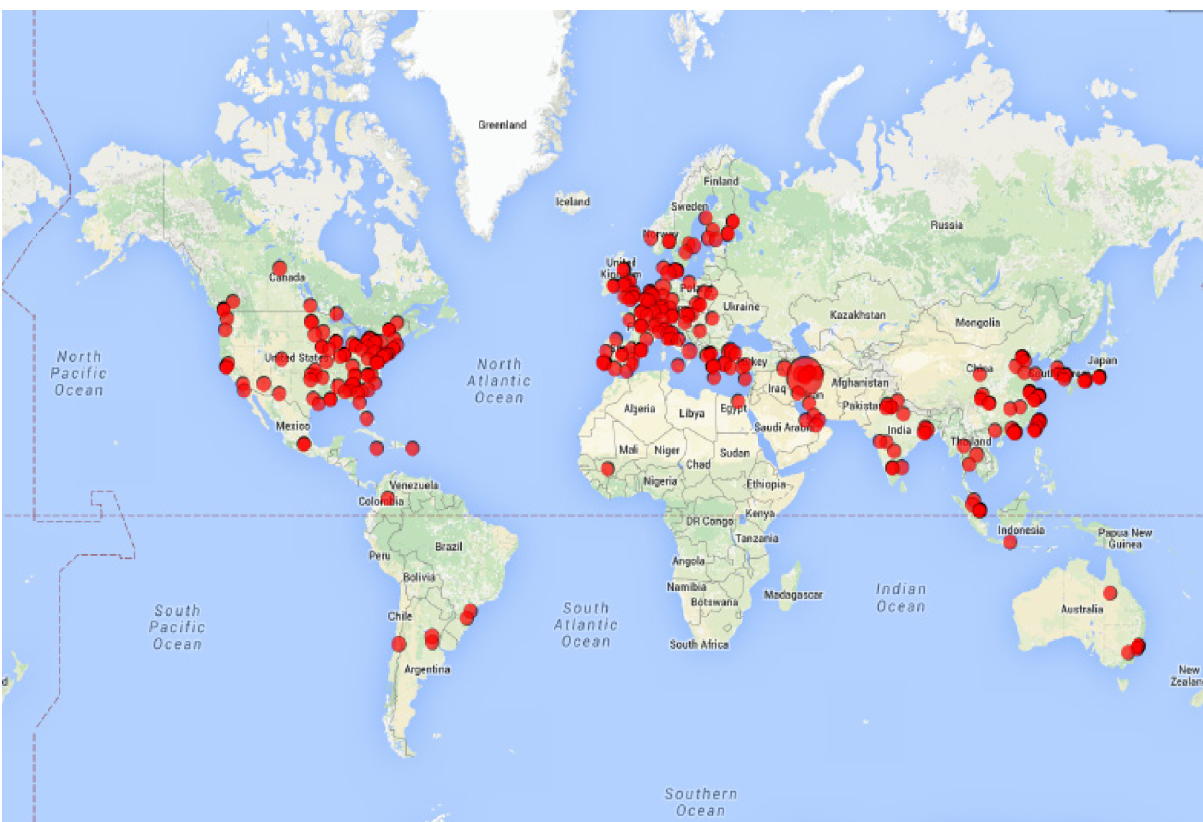
Figure 2. (Red circles) graphical location of all institutions